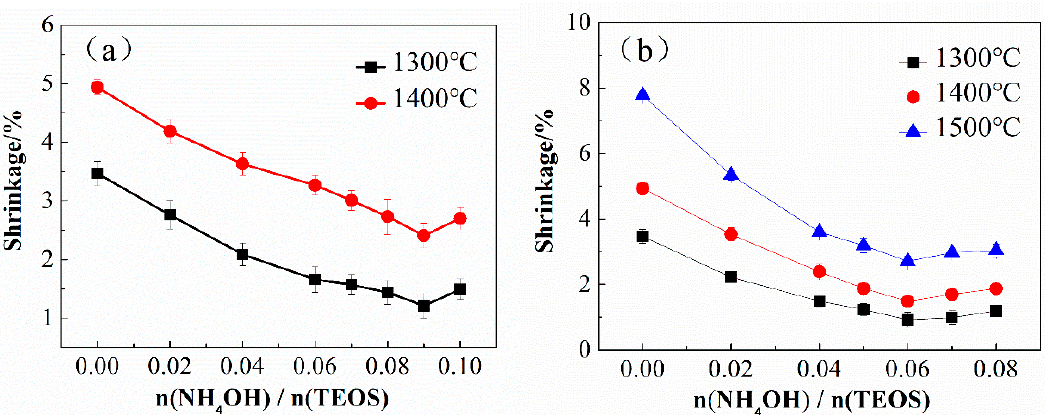
Figure 9. The shrinkage of the SiBCO aerogel composites with varying contents of TMB ( a ) and PBA ( b ) after heating in air at 1773 K for 30 min.